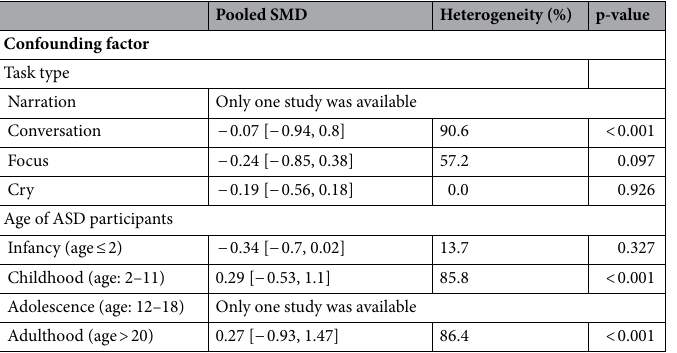
Table 6. Subgroup analyses for voice intensity difference between ASD and TD groups. The elicitation tasks and the age of participants were confounding factors.